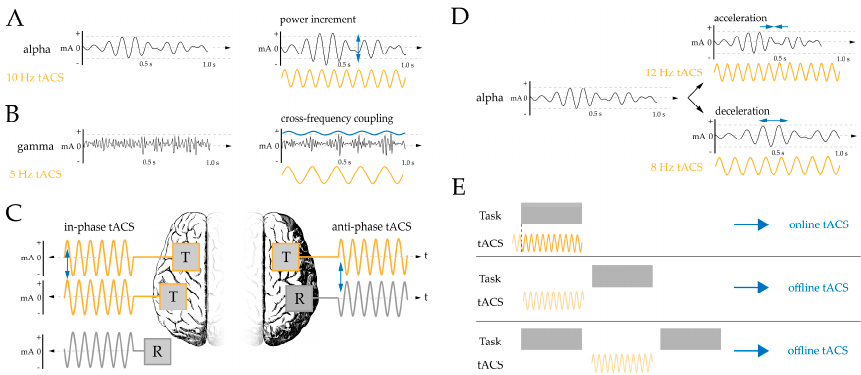
Figure 1. Overview of di ff erent ways to modulate brain oscillations ( A – D ). ( E ) Online tACS: applied during a cognitive task; o ffl ine tACS: applied either prior to a cognitive task or between tasks. Note: T, target electrode; R, return electrode; mA, milliamps; t,